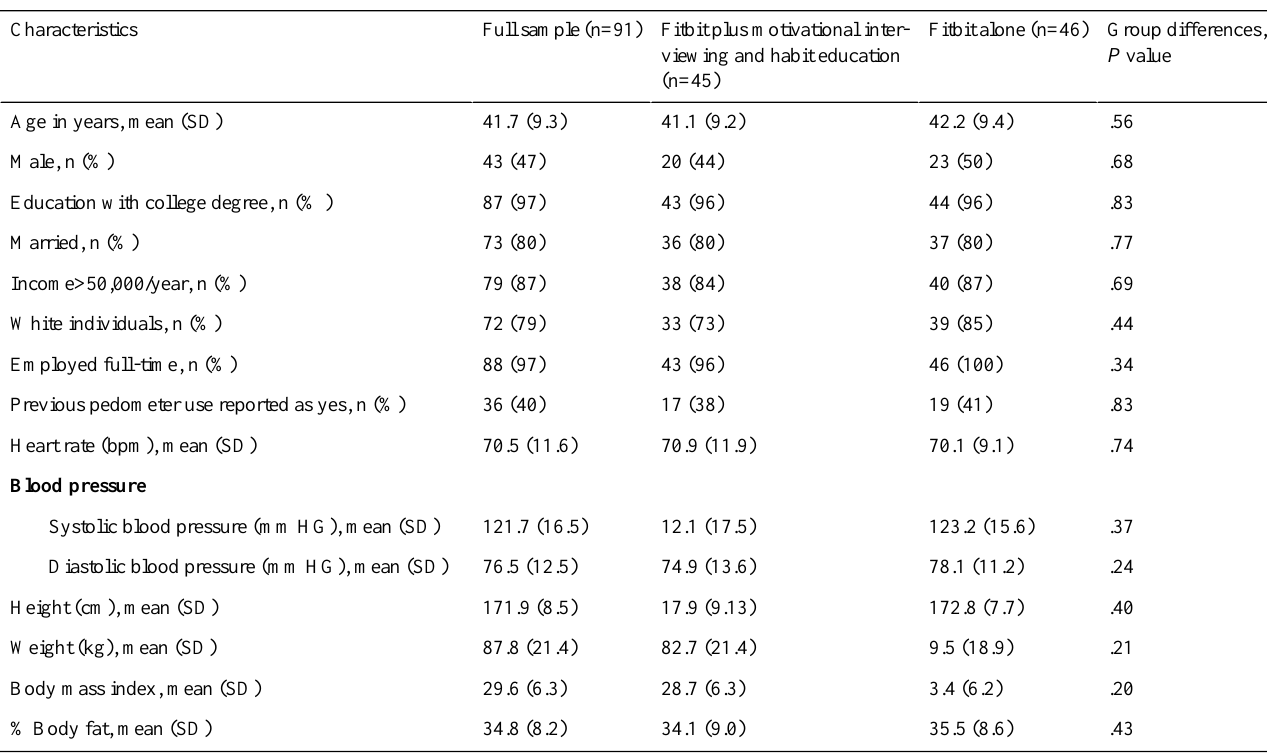
Table 1. Baseline participants’characteristics.